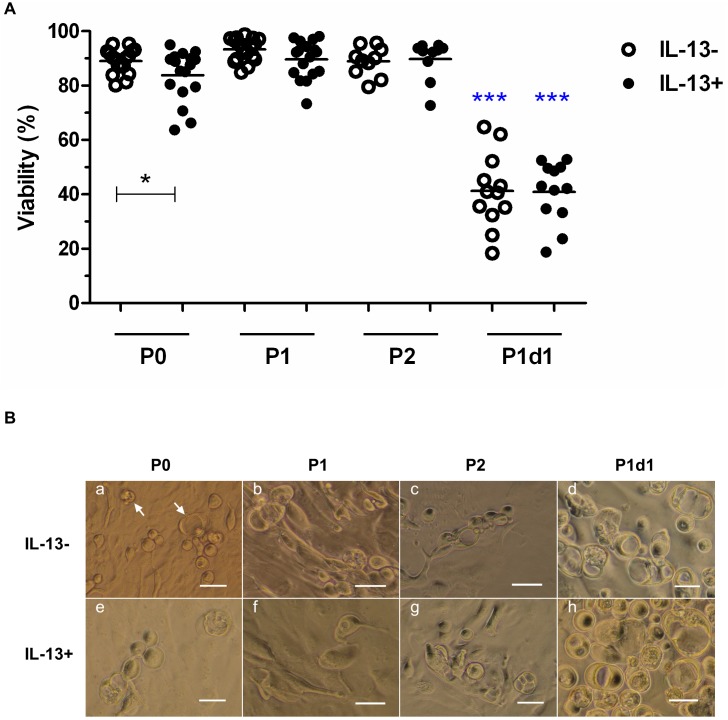
The viability and morphology of IL-13- or IL-13+ cell cultures.(A) Percentages of cell viability at the end of cultivation of P0, P1, and P2 cultures and percentages of cell viability of the unattached GC-enriched subpopulation harvested on P1d1. Cell viability data are presented in a vertical scatter plot graph with line indicating mean. *P < 0.05, ***P ≤ 0.001. Blue asterisks indicate significant decrease of viability in P1d1 IL-13- or P1d1 IL-13+ group vs. P0, P1, and P2 IL-13- or IL-13+ groups, respectively. (B) Cell morphology at the end of cultivation of P0, P1, and P2 cultures observed under inverted phase contrast microscope. P1d1 images show no attached GC-enriched subpopulations. White arrows show examples of GCs. Scale bars: 50 μm.